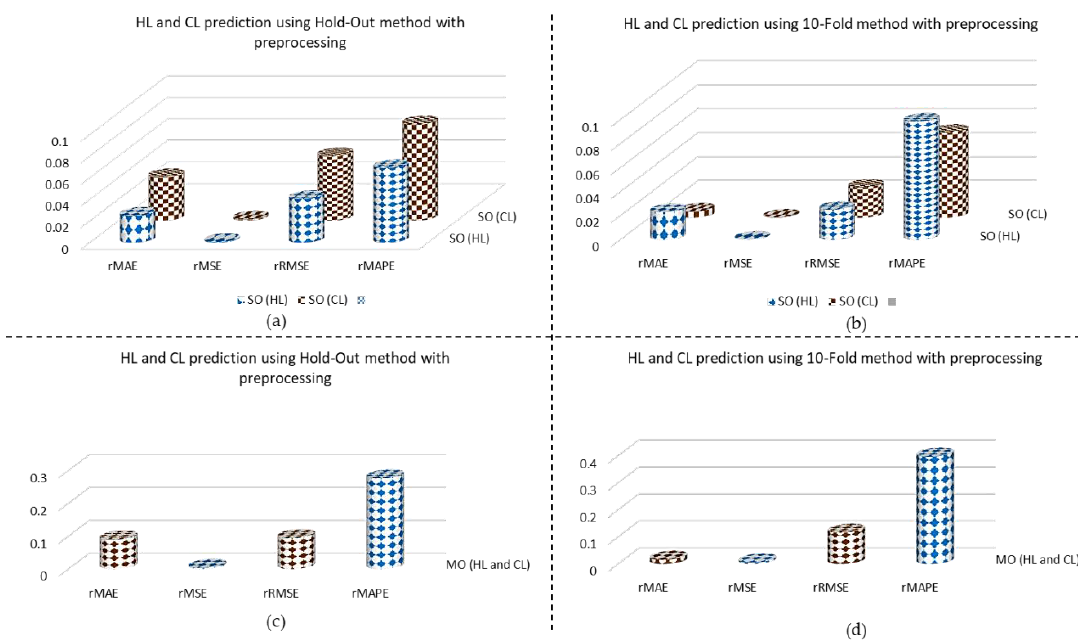
Figure 8. Experimental results of the proposed model (GRU) for SO and MO prediction using the hold-out and 10-fold methods.